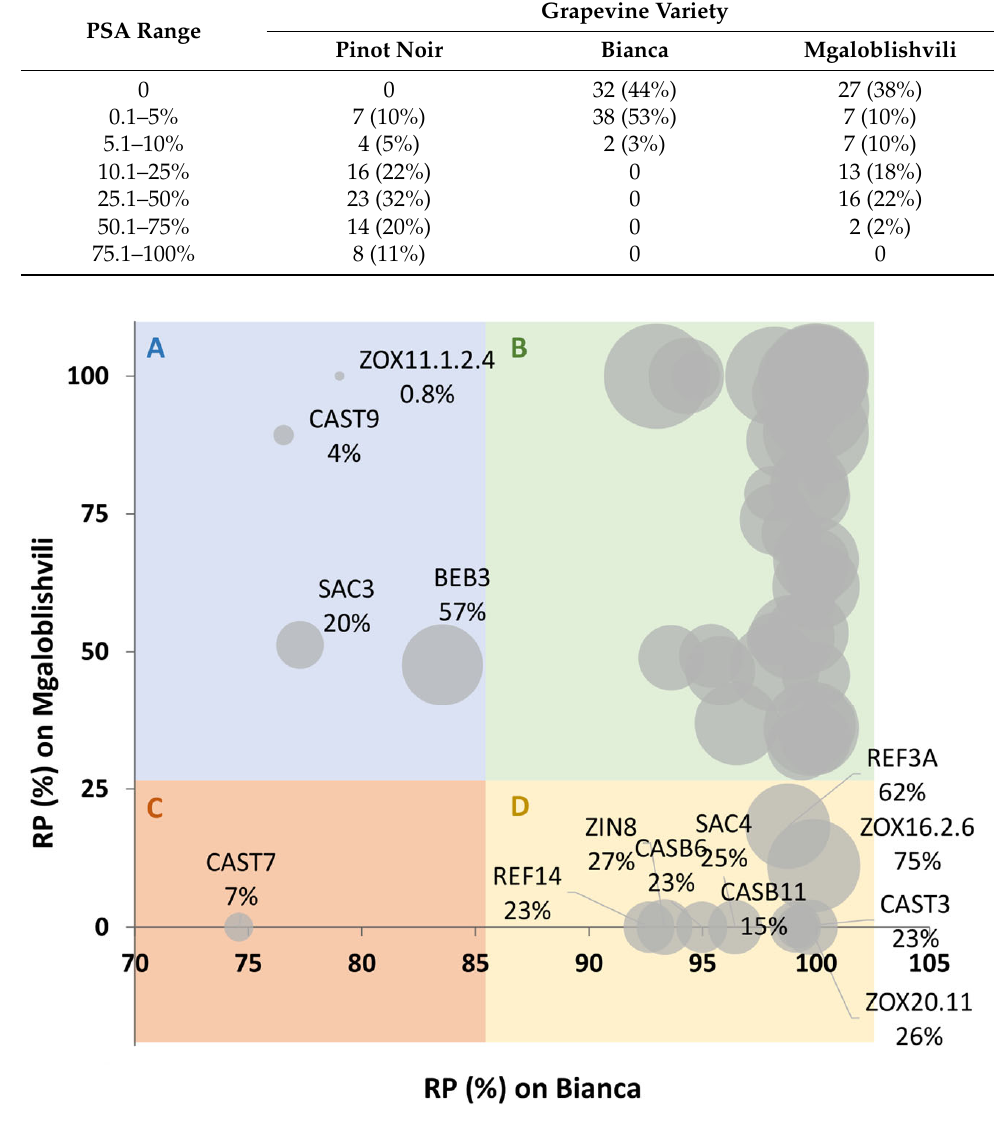
Figure 2. Bubble chart representing the percentage of PSA reduction (RP) on Bianca and Mgalob- lishvili compared to Pinot noir. The size of the bubbles represents the PSA value on Pinot noir (the greater the size, the greater the PSA value). Percentages below the isolate codes indicate the PSA values on Pinot noir. Only the codes of adapted P. viticola isolates are reported. ( A ) Isolates showing RP < 85% on B and RP > 25% on MG (B ‐ adapted). ( B ) Isolates with RP > 85% on B and RP > 25% on MG (non ‐ adapted). ( C ) Isolate with RP < 85% on B and RP < 25% on MG (B ‐ and MG ‐ adapted). ( D ) Isolates with RP > 85% on B and RP < 25% on MG (MG ‐ adapted).